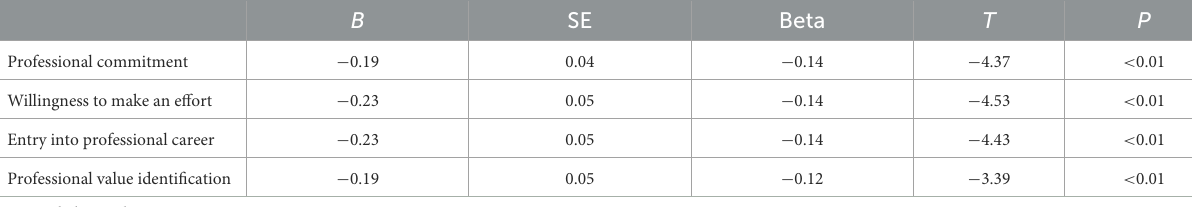
TABLE 6 Influence of psychological WPV on professional commitment of nursing interns. B